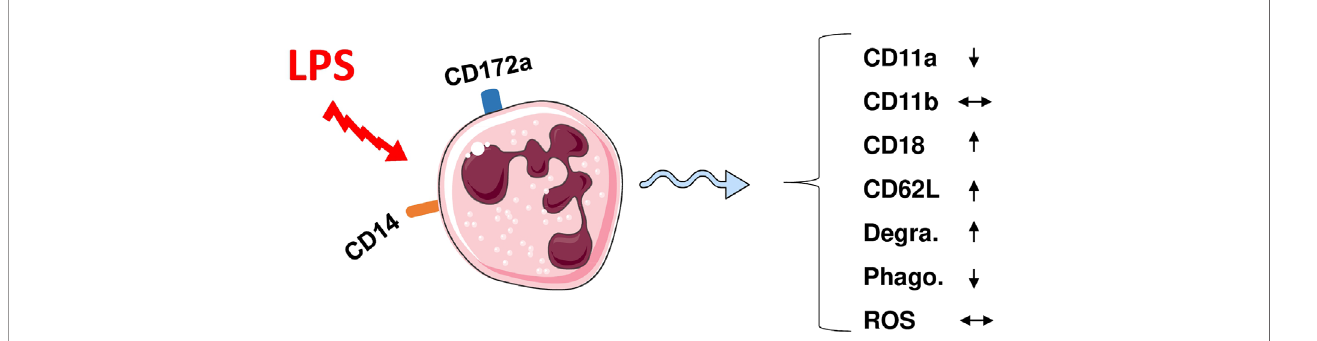
FIGURE 1 | Modulation of phenotype and function of camel neutrophils by LPS stimulation. Camel neutrophils can be identi fi ed as CD172a high SSC high leukocytes (CD45+) with low expression of CD14. Stimulation of whole camel blood with LPS induces the modulation of the expression pattern of different adhesion molecules and different antimicrobial functions (reduced SSC values as an indicator for neutrophil granularity, decreased phagocytosis capacity but no change in ROS production). Degra, Degranulation; Phago, phagocytosis; ROS, generation of reactive